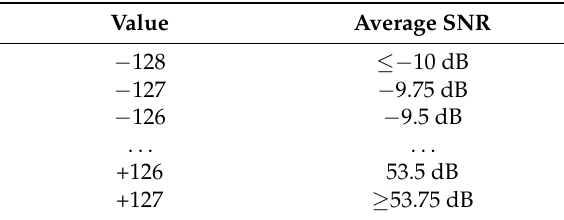
Table 1. SNR list.